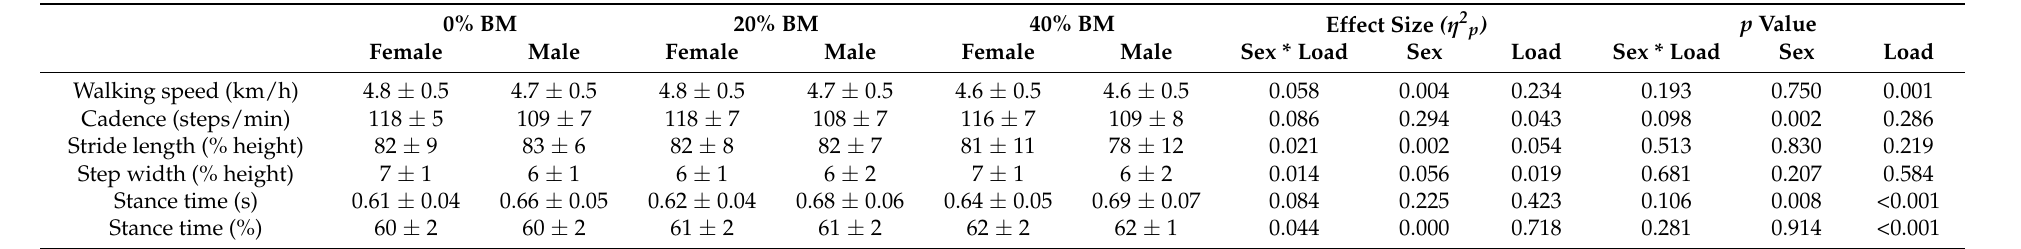
Table 2. Spatiotemporal measures in female and male participants across overground walking trials. Data presented as mean ± SD. BM: body